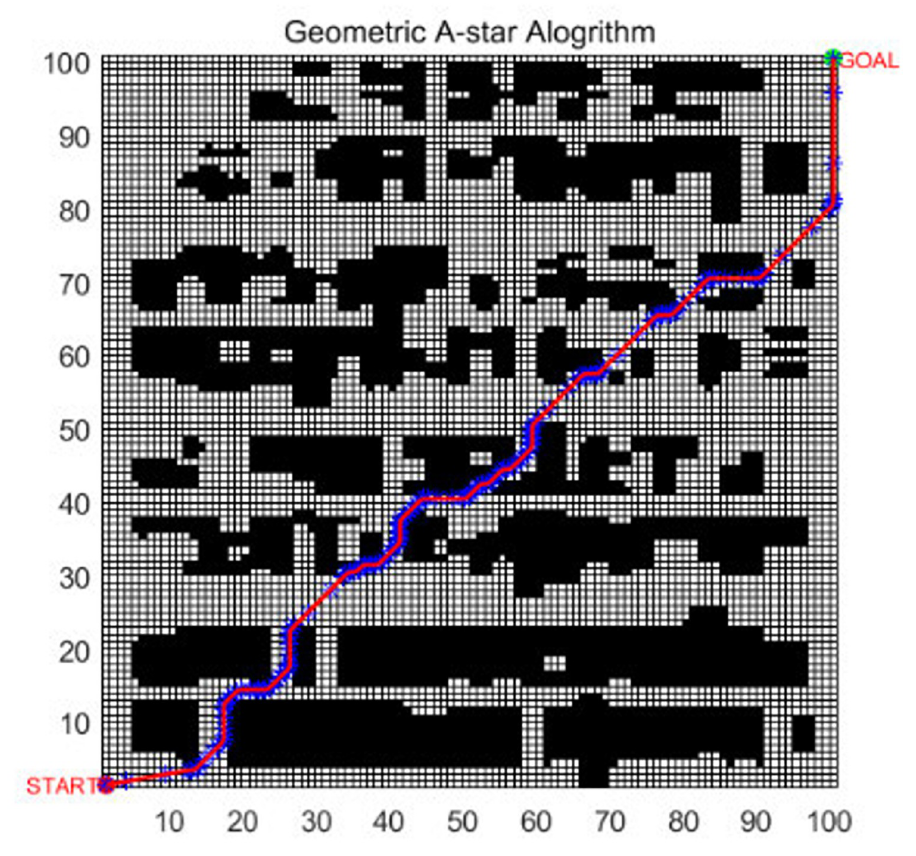
Fig 11. The path planning of the geometric A �